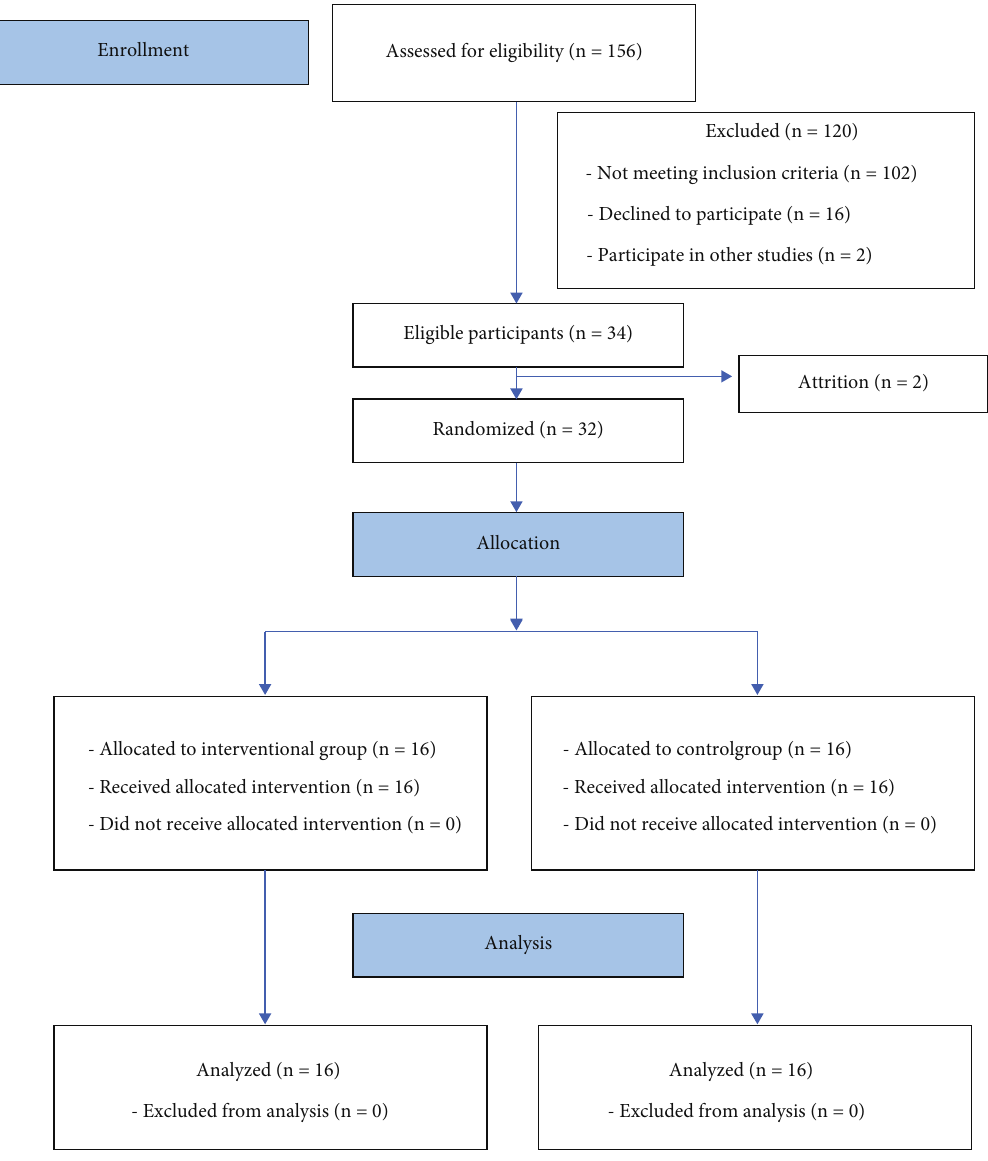
Figure 1: Flowchart of the